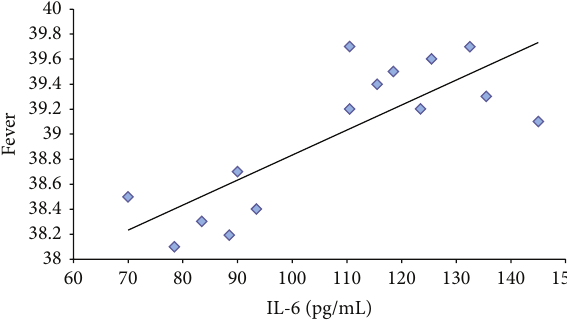
Figure 3: Box plot representation was used. H1N1 patients had significantly higher levels of IL-1 𝛽 ( 𝑃 = 0.0002 ) and IL-6 ( 𝑃 < 0.0001 ) when compared to controls.